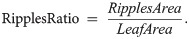
a)Binary image of smoothing edge by using disk filter b) Binary image of original leaf sample c) Ripples are
RipplesRatio=RipplesAreaLeafArea.(16)